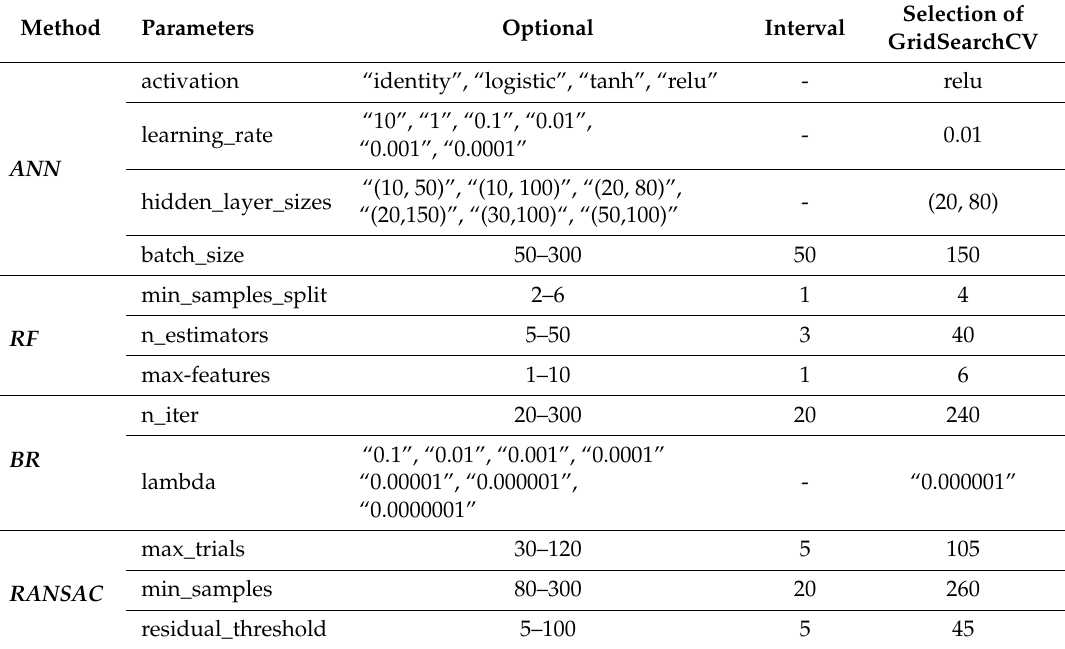
Table 3. Parameters setting to determine the optima parameters for ML